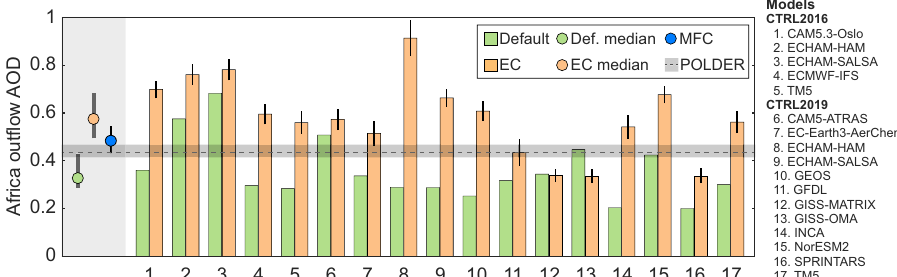
Fig. 5 | Estimated aerosol optical depth (AOD) over the out fl ow region of Southern Hemisphere Africa for AeroCom models. The Default results refer to the original model output. Two corrections (EC and MFC) are adopted over the source region (Southern Hemisphere Africa) only, and their results are based on our multivariate linear regression for AeroCom models. For the EC case, only emissions are rescaled according to the AOD errors in the source region. For the MFCcase,emission,lifetime,andMECarecorrectedtoourconstrainedvalues.The results for default, EC, and MFC cases are shown in green, orange, and blue, respectively.ThespreadofthemodelensemblefordefaultandECcasesareshown asdots(median)andtheinterquartileranges(thickgreyerrorbars)ontheleft.The